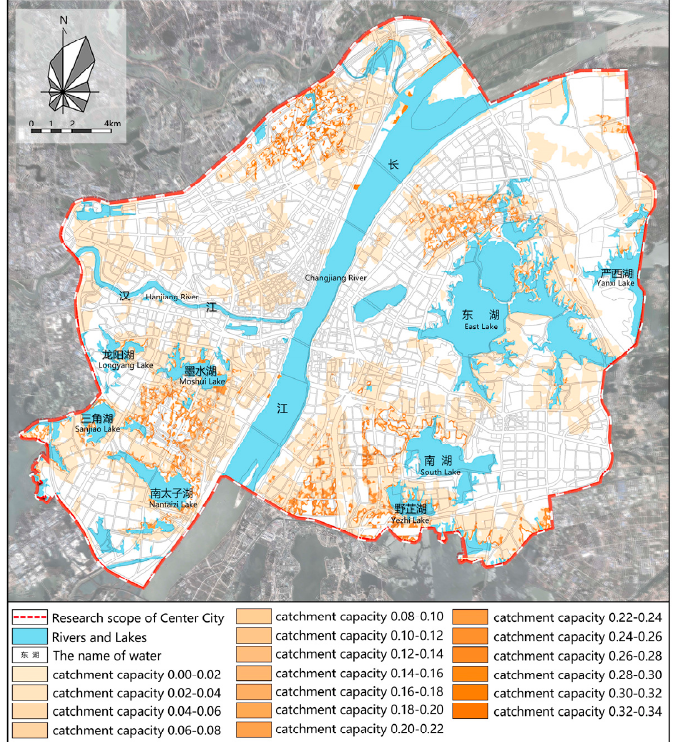
Figure 11. Catchment capacity of areas where the catchment capacity of the swales is greater than the rainfall volume of 100-year return period. Figure 12. Catchment capacity of downtown Wuhan. The maximum comprehensive surface runoff coefficient under the 100-year return period standard of the lots in downtown Wuhan was obtained based on the catchment- capacity simulation experiment, as shown in Figure 13. The coefficient was viewed as the final evaluation results of the rainwater storage capacity, i.e., the smaller the maximum surface runoff coefficient is, the larger that rainwater storage capacity will be. As dis- cussed before, the comprehensive surface runoff coefficient is functionally correlated with the green coverage. The minimum green coverage under this evaluation standard, i.e., the minimum ratio between the green area and the total area of a lot when the rainwater stor- age capacity gives the fullest play, would be obtained. The results, together with the other factors, were employed to define the green coverage of the 1530 lots in the Wuhan Com- prehensive Plan 2006–2020, as shown in Figure 14. When compiling future urban plans, the results can be used to analyze the green-space distribution characteristics in different land-use types and to adjust the use types accordingly.